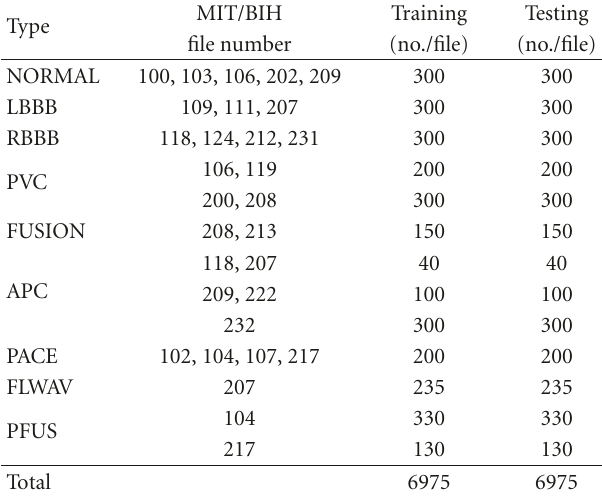
Table 1: The sources and the number of ECG samples used in this